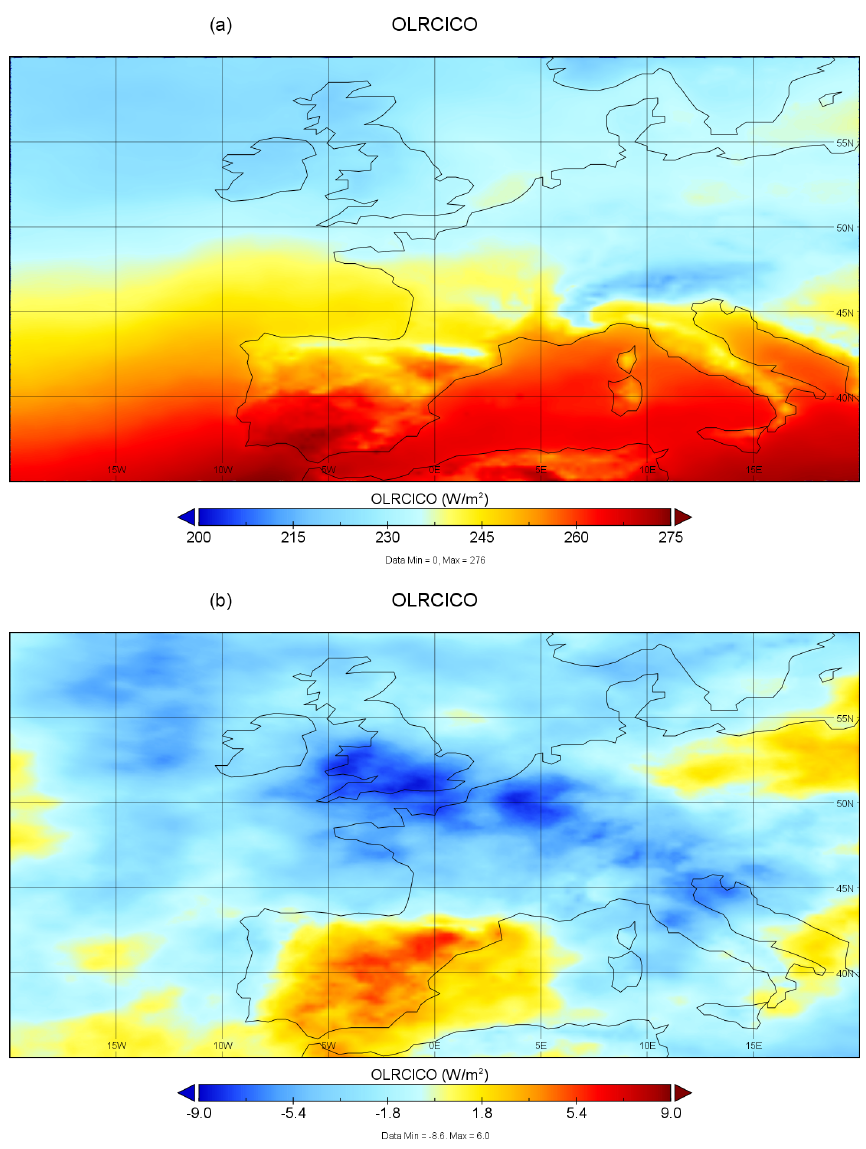
Figure 11. Mean outgoing longwave radiation (OLR) in Wm − 2 in the sum of IFS and CoCiP results from March–August in 2019 (a) and the 2019–2020 difference (b) .